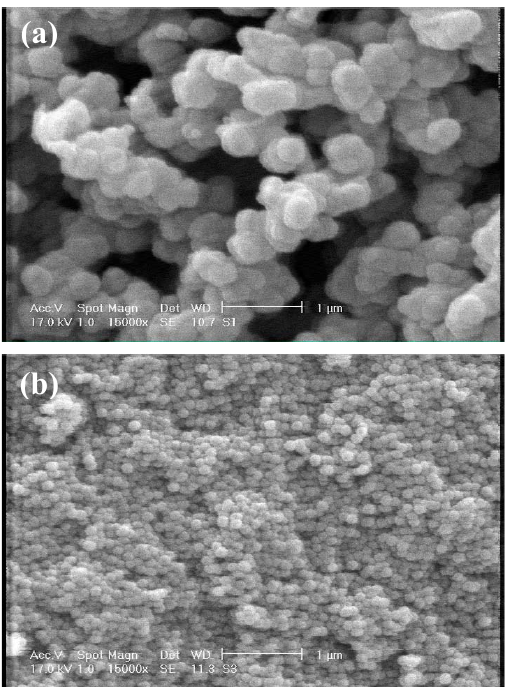
Fig. 2: Scanning electron micrograph of (a) polypyrrole/ titanium dioxide composite and (b) polypyrrole/titanium dioxide nanocomposite (with